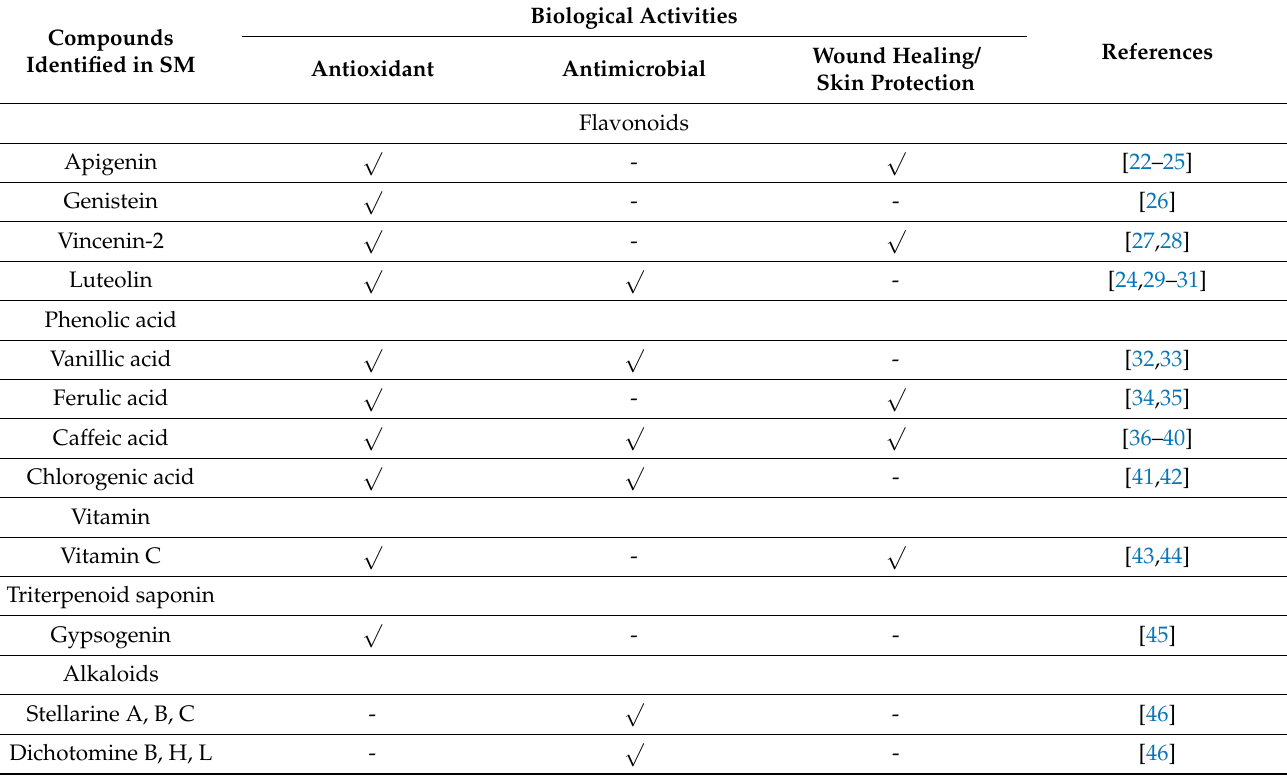
Table 3. Some biological activities of bioactive compounds identified in SM plants reported in the literature.